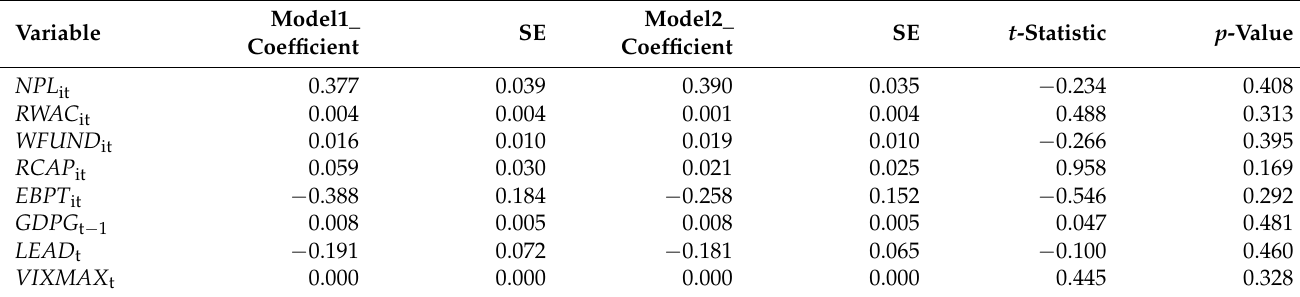
Table A12. Comparison of post-crisis (5) and post-crisis (adjusted) (6).